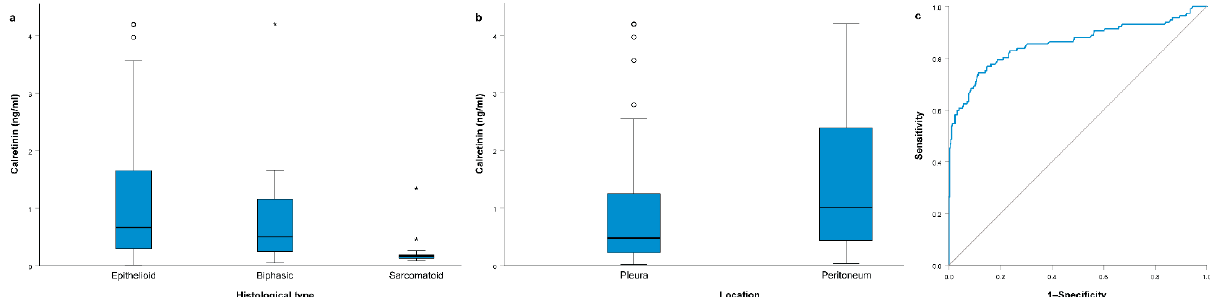
Figure 3. ( a ) Association of histological type with serum calretinin levels; ( b ) association of malignant mesothelioma (MM) location with serum calretinin levels; ( c ) ROC curve analysis for serum calretinin concentration comparing patients with epithelioid MM with all other subjects. All boxplots represent median with interquartile range, while outliers are represented using circles and extreme outliers are represented using * symbol.